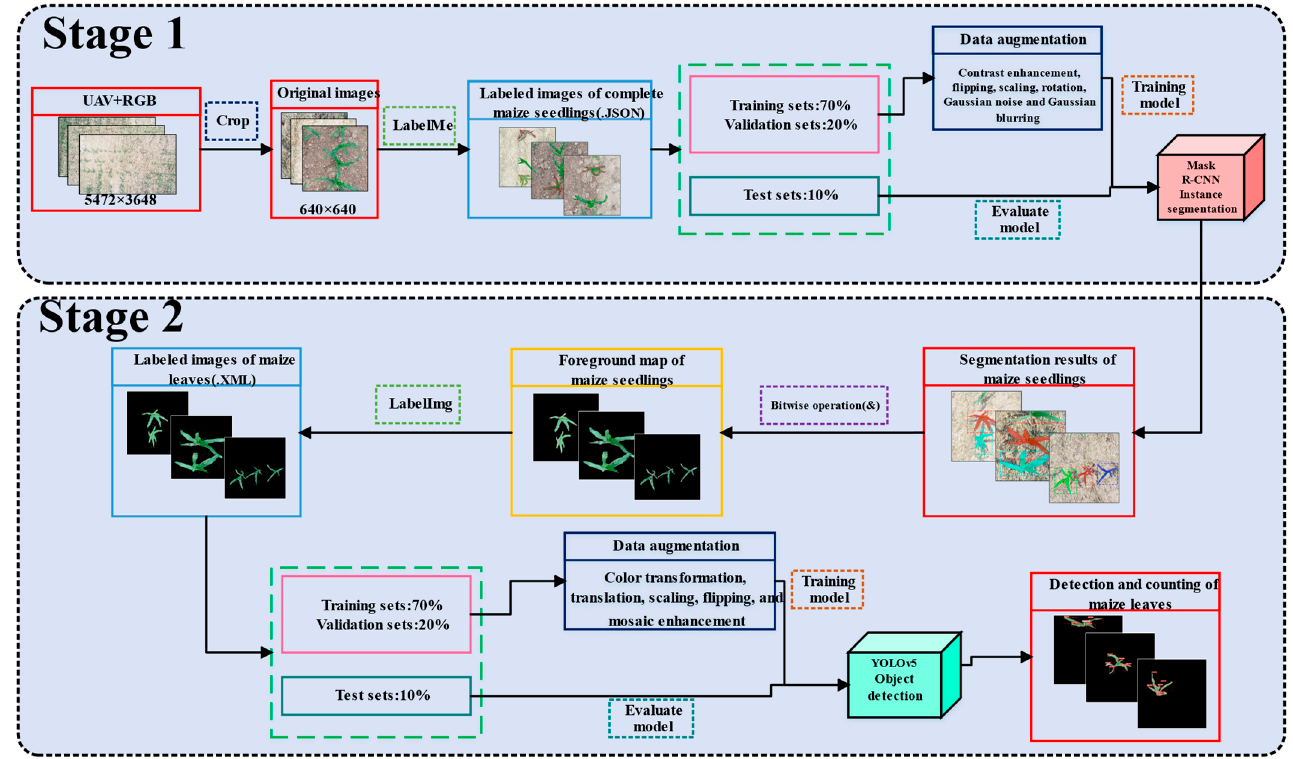
Figure 2. Flow chart of maize seedlings and leaves